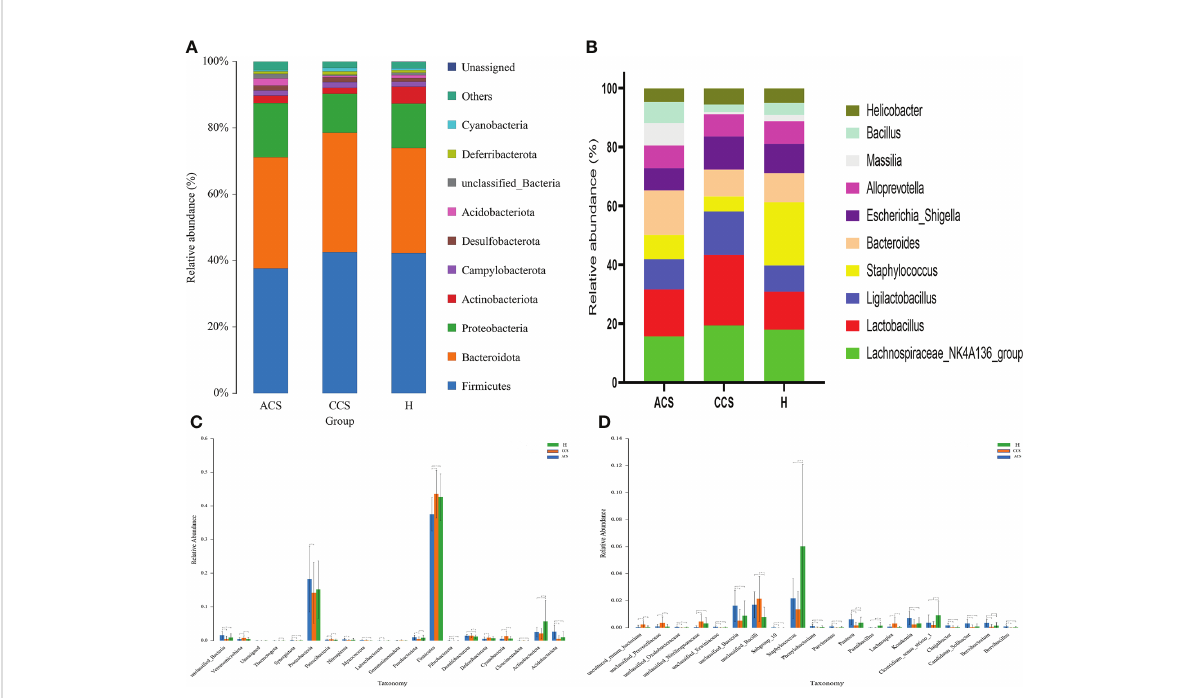
FIGURE 3 Composition of blood microbiota among acute coronary syndrome, chronic coronary syndrome, and healthy groups. (A) The data shown represent the top 10 most abundant phyla among acute coronary syndrome, chronic coronary syndrome, and healthy groups. (B) The top ten genera among acute coronary syndrome, chronic coronary syndrome, and healthy groups are shown by the data. (C) The ANOVA test indicates a signi fi cant change in the proportion among acute coronary syndrome, chronic coronary syndrome, and healthy groups at the phylum level. (D) A signi fi cant change in the proportion among acute coronary syndrome, chronic coronary syndrome, and healthy groups at the genus